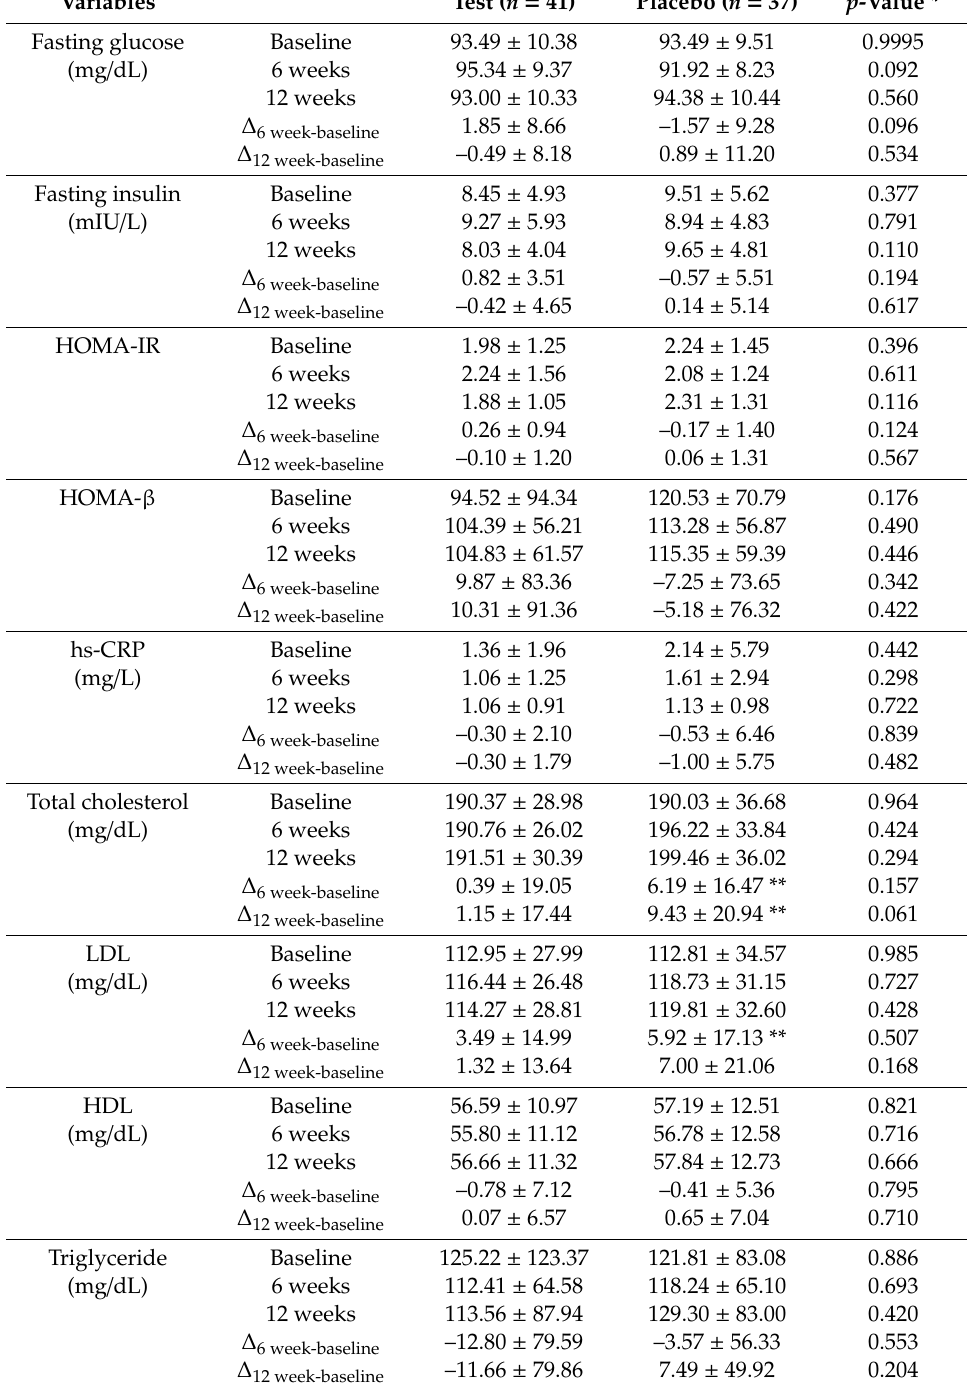
Table 5. Fasting glucose and lipid